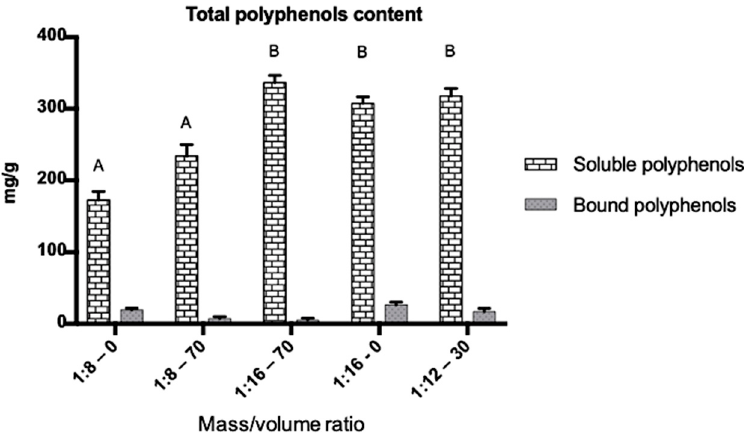
Figure 3. The total content of soluble and boundpolyphenolsin RP. The best extraction conditions 1:16-0 with 307.57 mg / g ± 20.27 mg / g, then 1:16-70 with 318.55 mg / g ± 18.96 mg / g and 1:12-30 with were 1:16-0 with 307.57 mg/g ± 20.27 mg/g, then 1:16-70 with 318.55 mg/g ± 18.96 mg/g and 1:12-30 311.09 mg / g ± 29.36mg / g. According to Tukey’s test means with the same letter are not significantly with 311.09 mg/g ± 29.36mg/g. According to Tukey’s test means with the same letter are not di ff erent ( p ≤